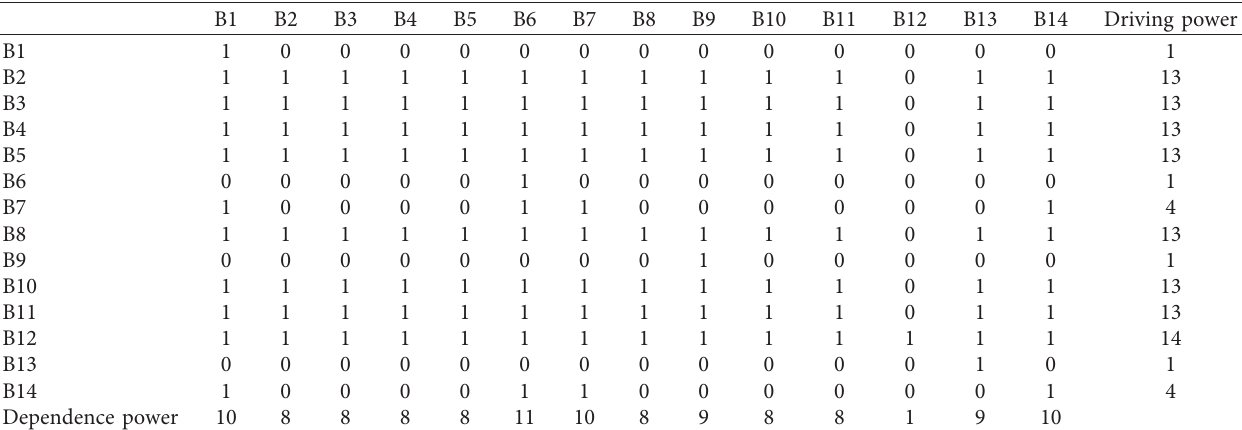
Table 6: Reachability matrix.